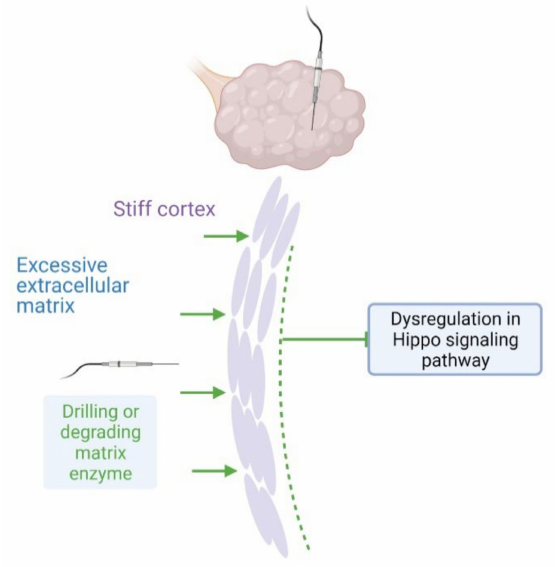
Figure 5. The schematic hypothesis for correlation of polycystic ovary syndrome (PCOS) and Hippo signaling pathway. (1) The mechanical damage and/or degrading enzyme approaches or (2) local administration of the Hippo downstream CCN growth factors and/or actin polymerization drugs for disruption of Hippo signaling aim to ameliorate the dysregulation of Hippo signaling pathway in PCOS patients for resumption of follicle